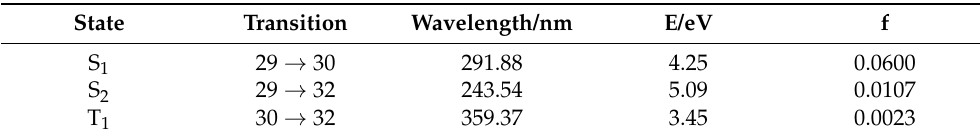
Table 1. Wavelength, vertical excitation energy (E), oscillator strength (f) and transition orbital of S 1 , S 2 and T 1 states of o -fluoroaniline molecules. Calculation method and basis set: TD-DFT and